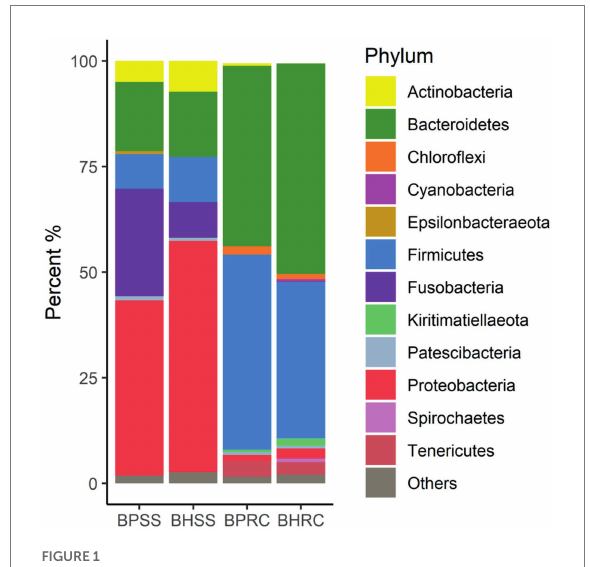
FIGURE 1 Relative abundance of bacterial communities at the phylum level, identified in the dental biofilm of clinically healthy cattle ( n = 25) and cattle with periodontitis ( n = 21; BHSS and BPSS, respectively), and in the ruminal microbiome of bovines with periodontal disease ( n = 13) and clinically healthy bovines ( n = 9; BPRC and BHRC,